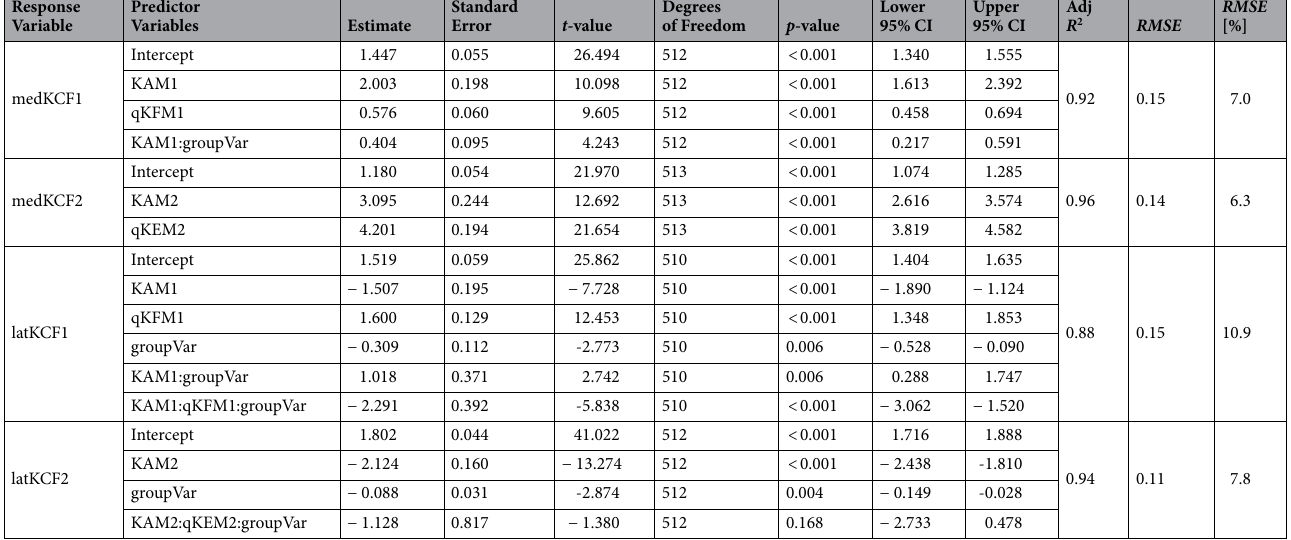
Table 4. Statistical summary of the linear mixed-effects models between the internal knee joint contact forces and external knee joint moments for the complete dataset (patient and typically developed healthy control group). CI: Confidence interval; Adj. R 2 : adjusted R 2 ; RMSE : root mean squared error [BW]; medKCF1/ medKCF2: max. value in the first/second half of stance of the medial knee joint contact force [BW]; latKCF1/ latKCF2: max. value in the first/second half of stance of the lateral knee joint contact force [BW]; KAM1/ KAM2: max. value in the first/second half of stance of the external knee adduction moment [Nm/kg]; qKFM1/ qKEM2: squared maximal/minimal value in the first/second half of stance of the external knee flexion/ extension moment (KFM1, KEM2; [Nm/kg]).